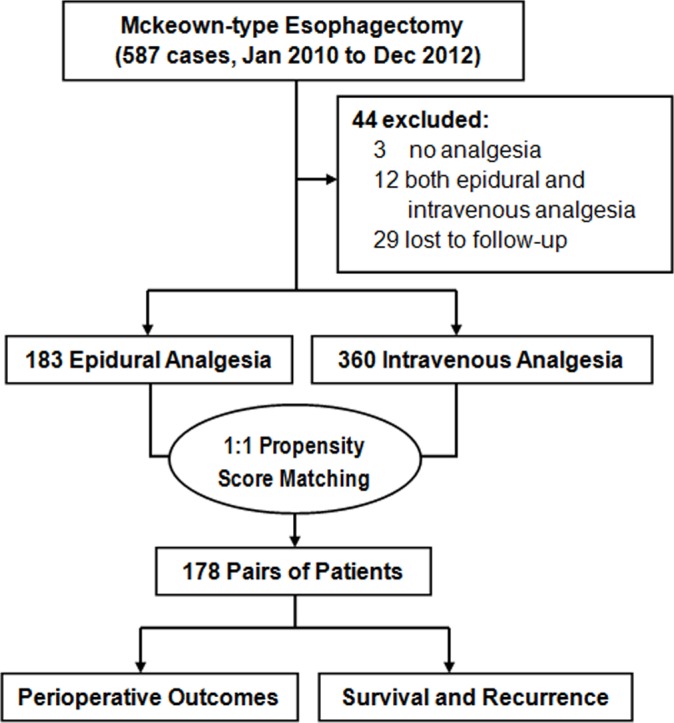
The selection and matching process of participants.